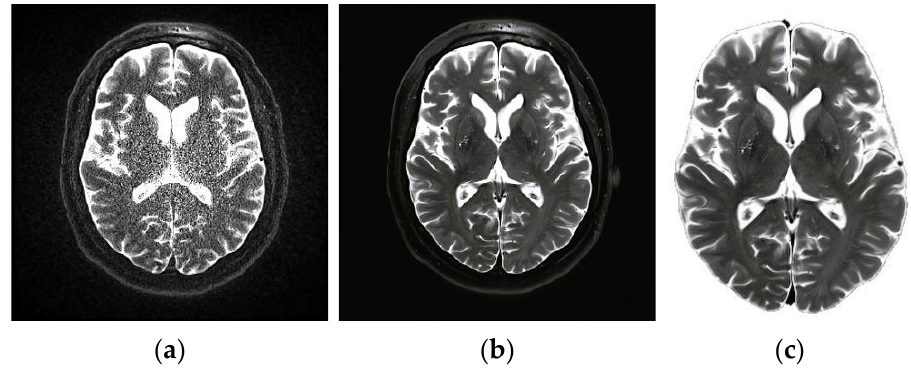
Figure 2. ( a ) Noisy MRI image, ( b ) filtered image, ( c ) and output of skull elimination.